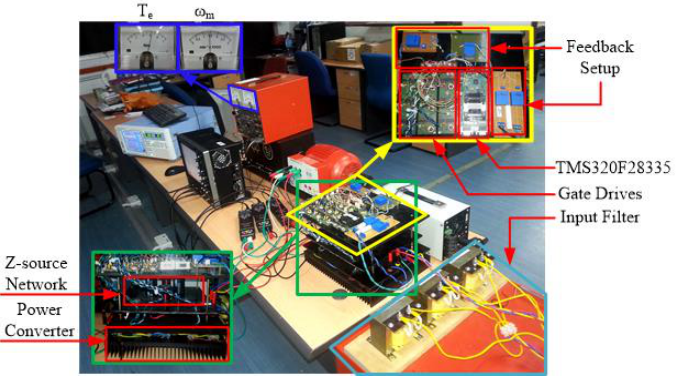
Figure16. Photograph of the experimental setup. Figure 16. Photograph of the experimental setup. Energies 2016 , 9 , 899